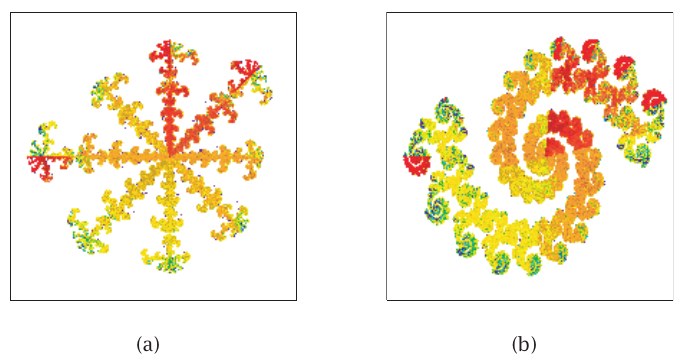
Figure 5.2 . Mixed iteration of contractive Möbius maps.